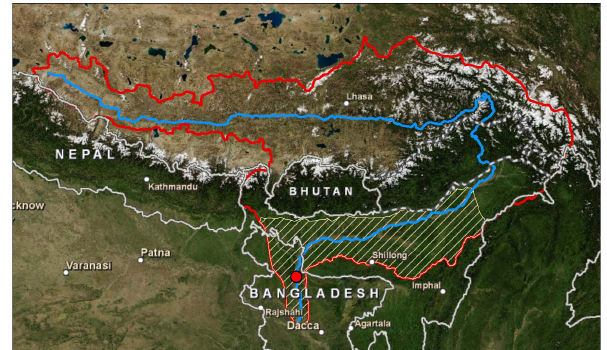
Fig. 1. Overview of the Brahmaputra river basin (red polygon), the Brahmaputra river (blue line), the outlines of the lower Brahmaputra river basin (shaded white) and the Bahadurabad gauging station (red